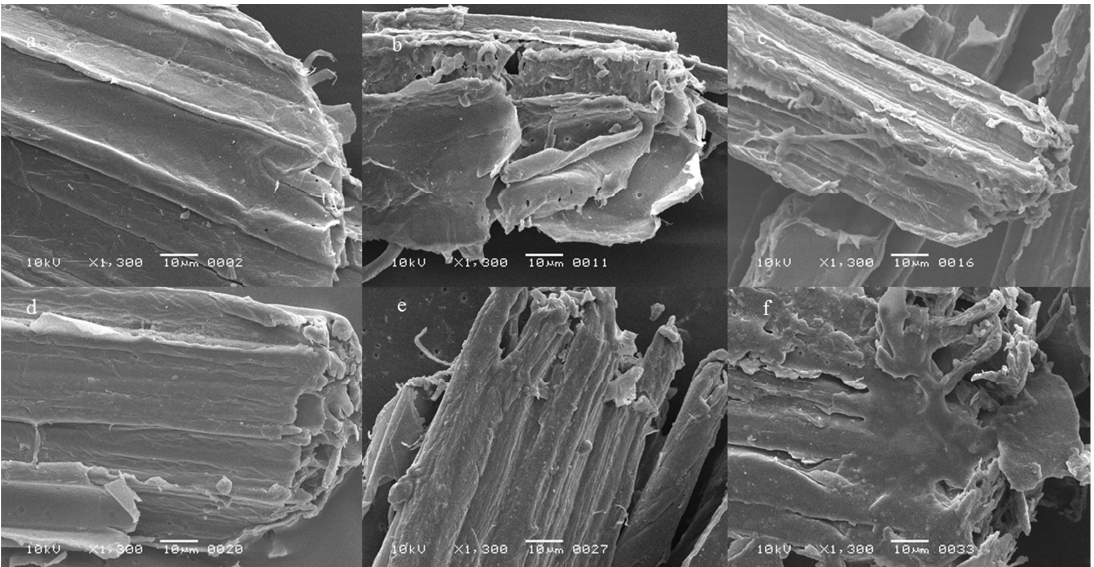
Figure 4. Scanning electron microscopy of ( a ) alkali pre-treated SB, ( b ) alkali pre-treated SB obtained after experiment 1, ( c ) after experiment 2, ( d ) after experiment 3, ( e ) after experiment 4, ( f ) after experiment 5.